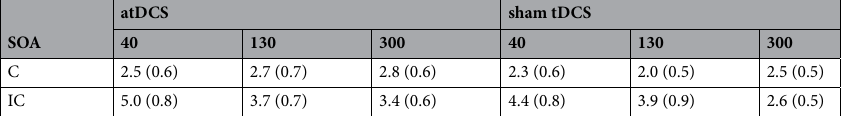
Table 2. PE2 as a function of Stimulation condition (atDCS vs. sham tDCS), SOA (40 vs. 130 vs. 300 ms), Compatibility (compatible vs. incompatible). Standard errors of the mean are presented in parentheses.